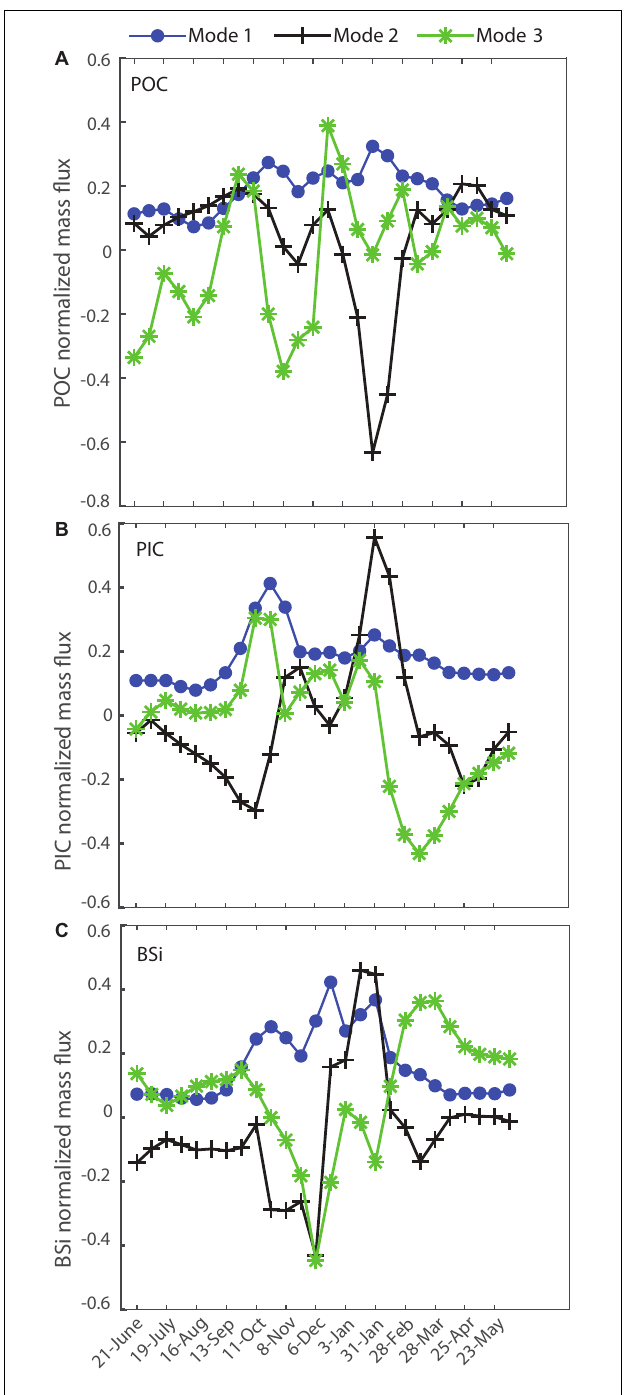
FIGURE 11 | Singular Value Decomposition Modes for the particle component fluxes at 1000 m (A) POC, (B) PIC, (C) BSi.